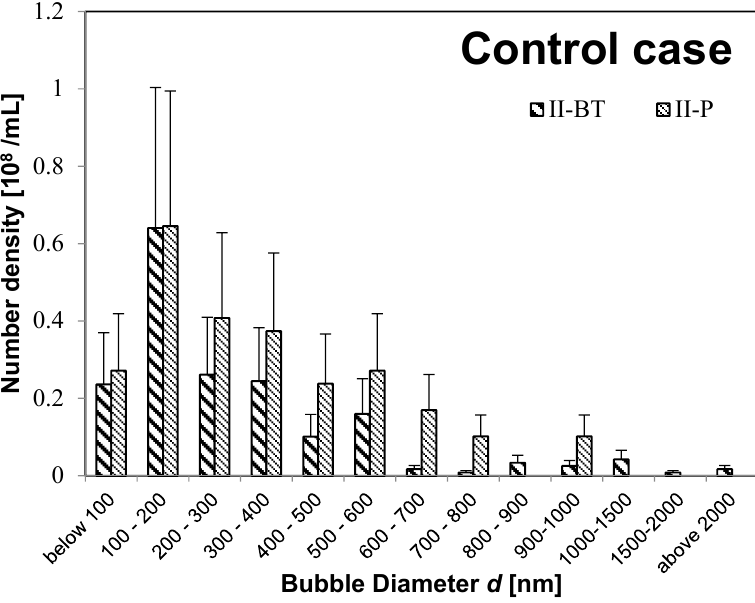
Figure 3. Number of fine bubbles of control case: II-BT (thick oblique line), and II-P (thin oblique line).